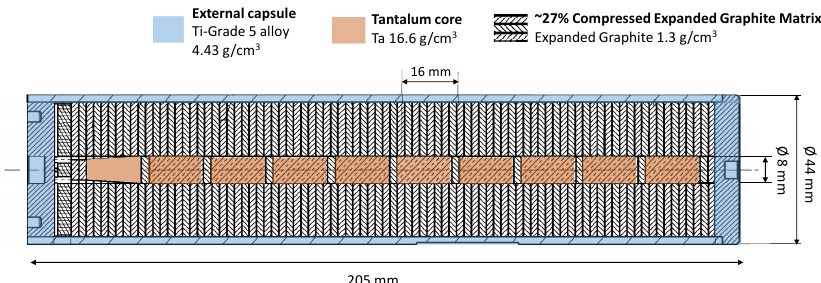
Figure 8. Geometry of the HiRadMat-42 target inspected by neutron imaging in the session of 2017